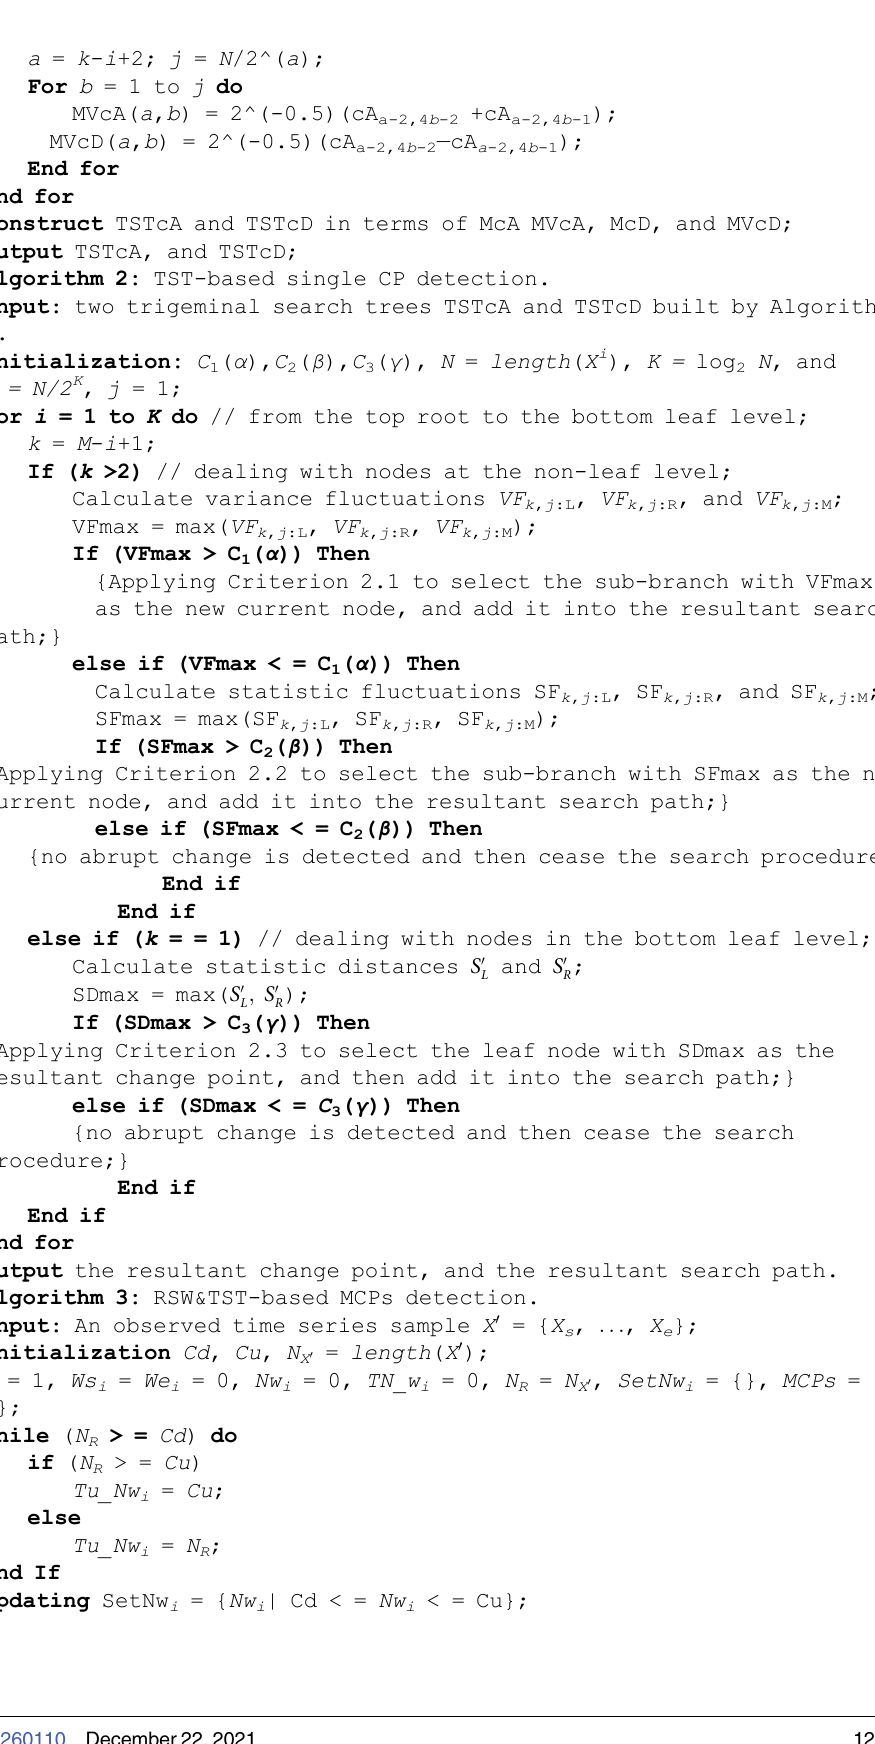
Algorithm 2: TST-based single CP detection.